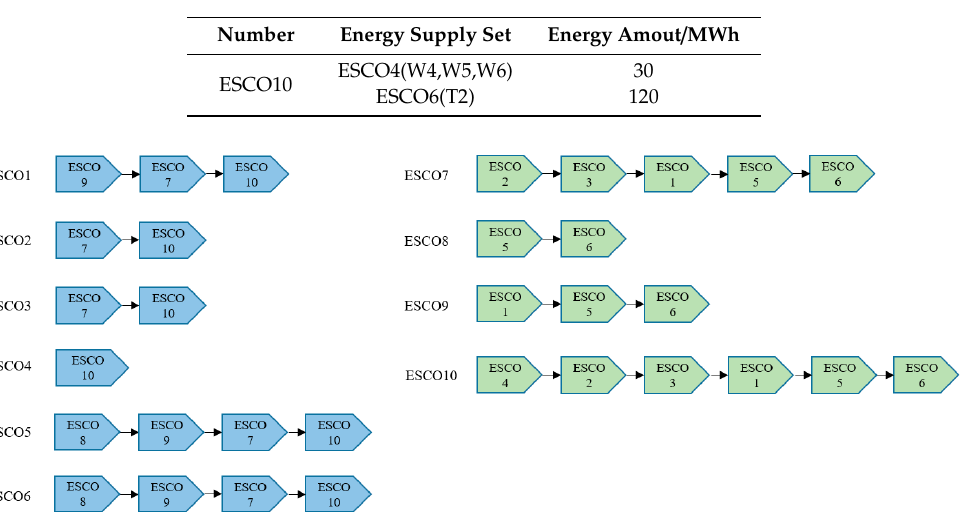
Table 8. Simulation results of ESCO10 in the EBN.